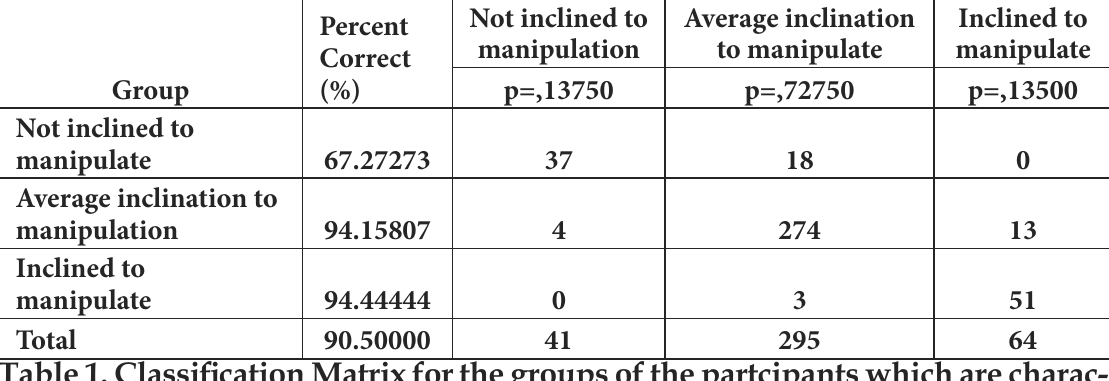
Table 1. Classi (cid:222) cation Matrix for the groups of the partcipants which are charac- terized as having low, average and high level of manipulation propensity Source: Own